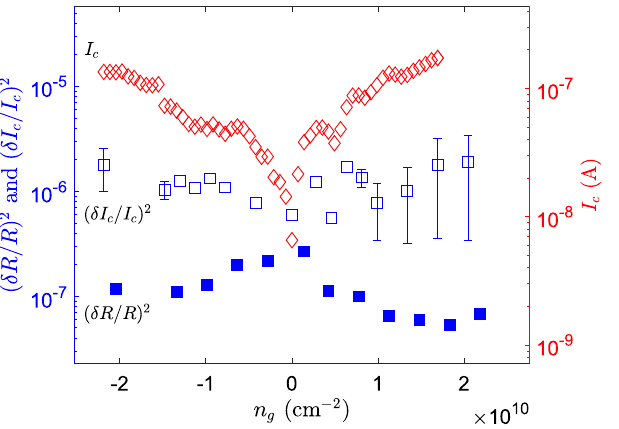
2 ( (cid:31) ), calculated from noise spectra measured